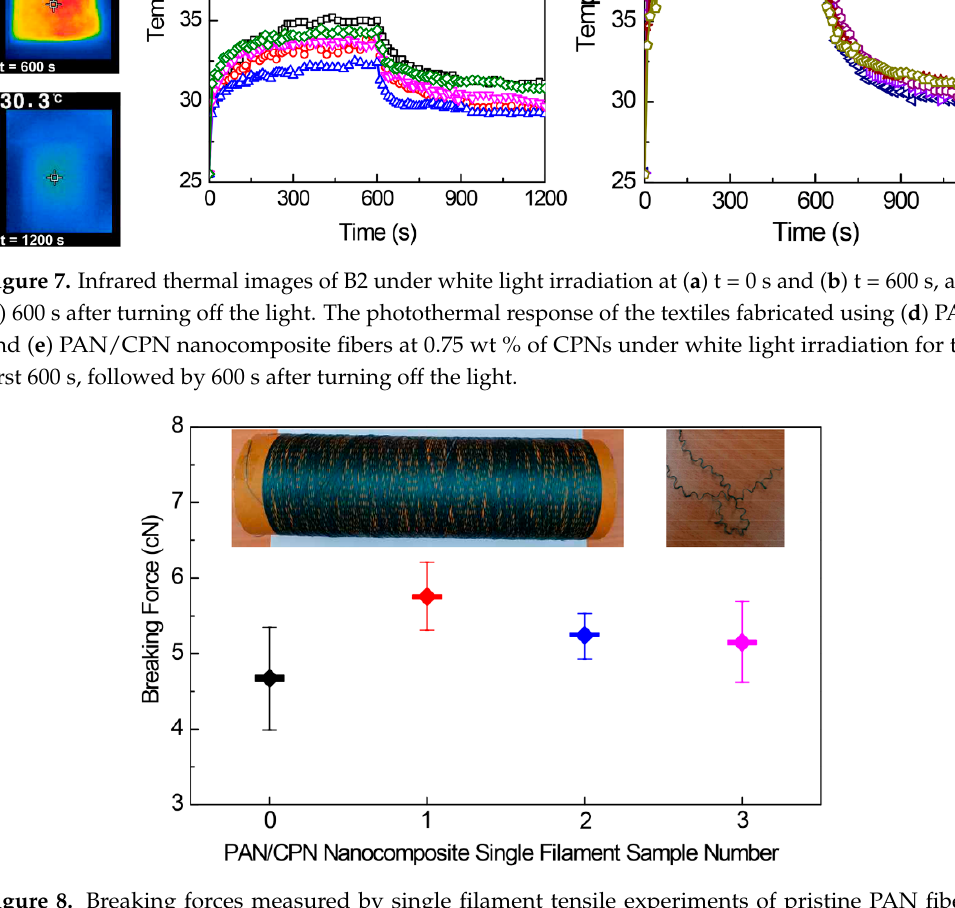
Figure 8. Breaking forces measured by single filament tensile experiments of pristine PAN fibers (filament 0), nanocomposite fibers before knitting the textiles (filament 1, left inset image), after knitting followed by deknitting without washing (filament 2), and after washing in a laundry machine followed by deknitting (filament 3, right inset image).